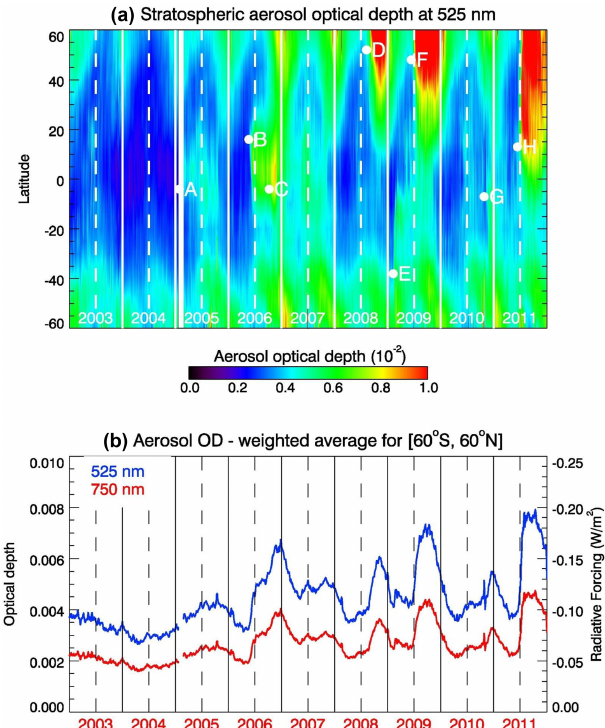
Figure 7. Top panel: stratospheric aerosol optical depth field at 525nm wavelength and integrated from the 380 K isentrope up to 40km as a function of time and latitude with daily resolution. The letters indicate the same events as in Fig. 6. Bottom panel: strato- spheric aerosol optical depth at 525 and 750nm wavelength inte- grated from the 380K isentrope up to 40km and corresponding to a surface-area weighted average between 60 ◦ S and 60 ◦ N (left ordi- nate). The right ordinate of the bottom panel shows the stratospheric aerosol radiative forcing determined using the approach discussed by Hansen et al. (2005) as described in the text (Note inverted scale). The right ordinate only applies to the blue line, i.e., 525nm wave-